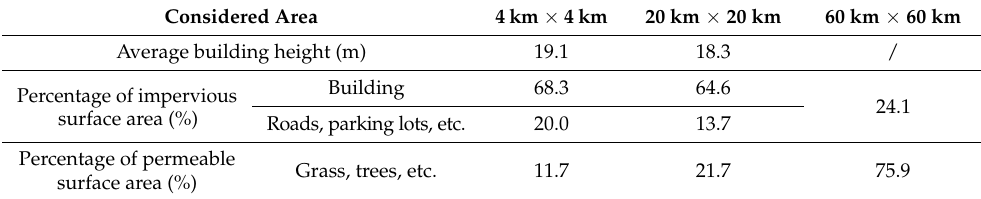
Figure 2. Mesh grid of the topographic model satellite image of the landforms around the 325 m meteorological tower in Beijing in 2020 ( a ), and a picture of the tower ( b ). Table 1. The parameters of the land and buildings around the tower.